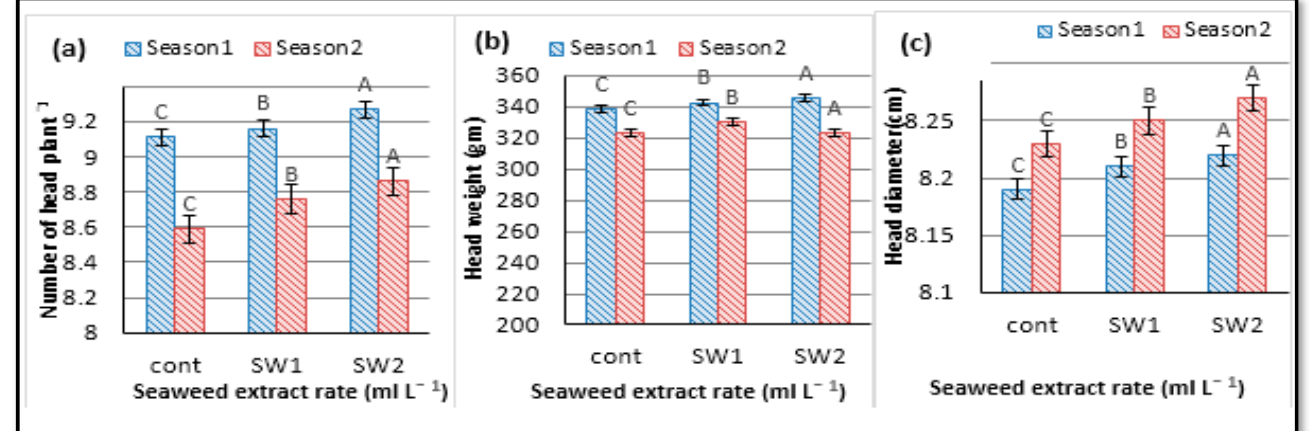
Figure 4. Head characteristics (mean ± SE) of globe artichoke as affected by the seaweed extract rate (Control: without, SW 1 : 5 and SW 2 : 10 mL L − 1 ) on ( a ) Number of heads plant − 1 ; ( b ) Head weight (g) and ( c ) Head diameter (cm). Letters in the figures indicate that the mean ± SE of treatments with the same letters were not significantly different according to Duncan’s multiple range test for p < 0.05. Table 4. Head characteristics of globe artichoke as affected by the interaction between PK fertilizer levels and seaweed extract